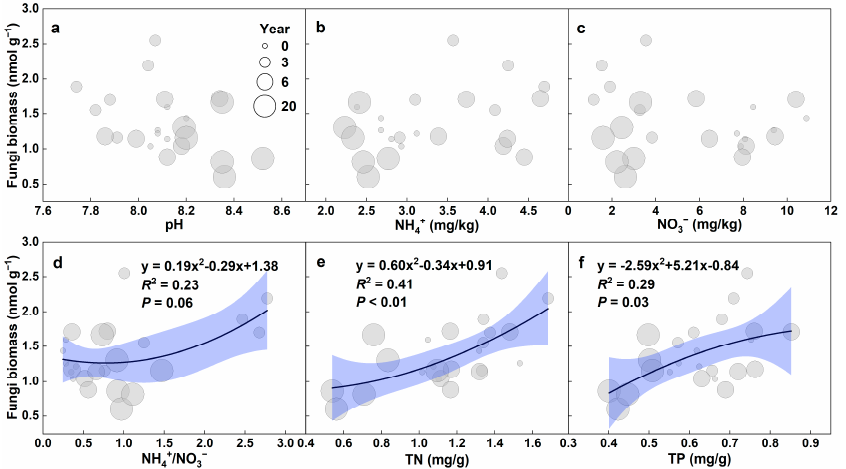
Figure 6. Relationships of fungi biomass (nmol·g − 1 ) with soil properties (pH, ( a ); NH 4+ , ( b ); NO 3 − , ( c ); NH 4+ /NO 3 − , ( d ); TN, ( e ); TP, ( f )). See abbreviations in Table 2.